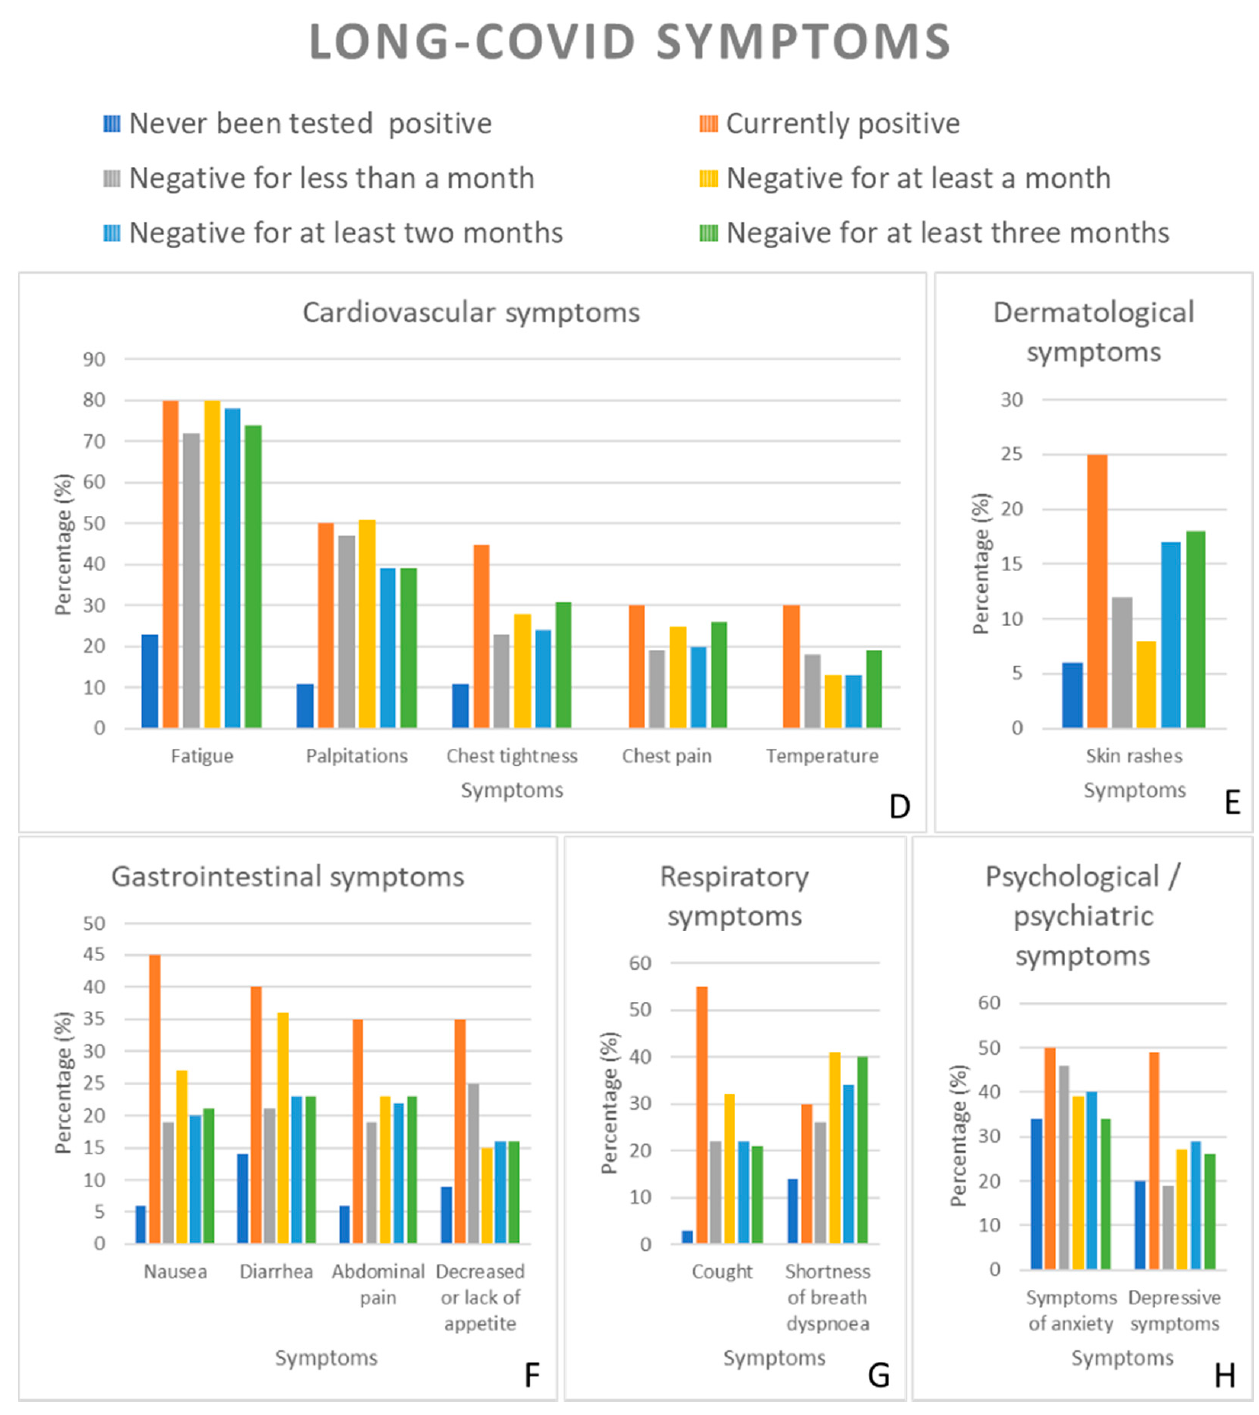
Figure 2. Percentages of symptoms reported by subjects in different COVID-19 conditions. The symptoms were divided into sub-categories: Musculoskeletal symptoms ( A ); Neurological symptoms ( B ); Symptoms regarding the ear, nose, throat, and sight ( C ); Cardiovascular symptoms ( D ); Dermatological symptoms ( E ); Gastrointestinal symptoms ( F ); Respiratory symptoms ( G ); Psychological/Psychiatric symptoms ( H ).